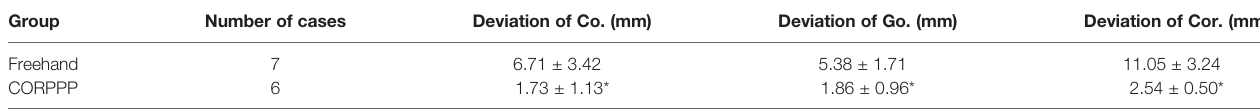
TABLE 2 | Deviation comparison between CORPPP group and freehand group in patients without ramus reconstruction. Group Number of cases Deviation of Co. (mm) Deviation of Go. (mm) Deviation of Cor. (mm)